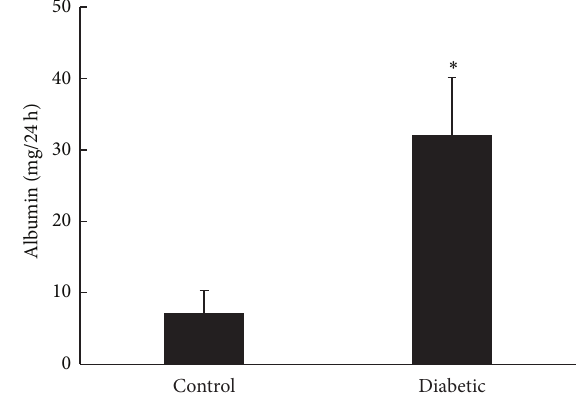
Figure 1: Twenty-four UAE in diabetic rats versus control rats. ∗ 𝑃 < 0.01